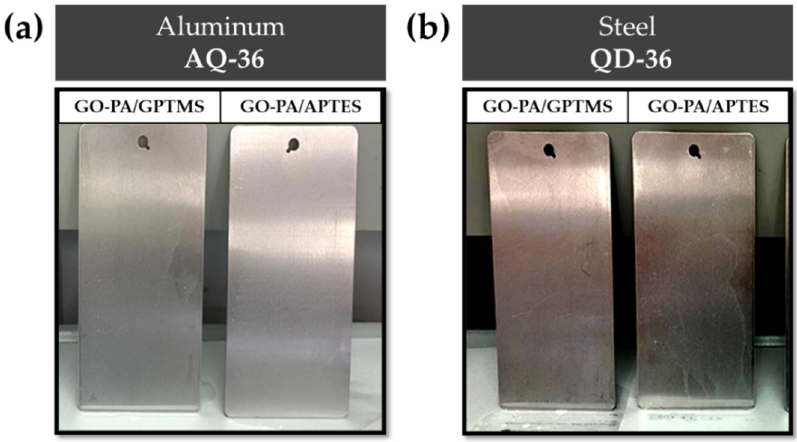
Figure 19. Aluminum AQ-36 panels ( a ) and QD-36 steel panels ( b ) treated with GO-PA-based coat- ings.